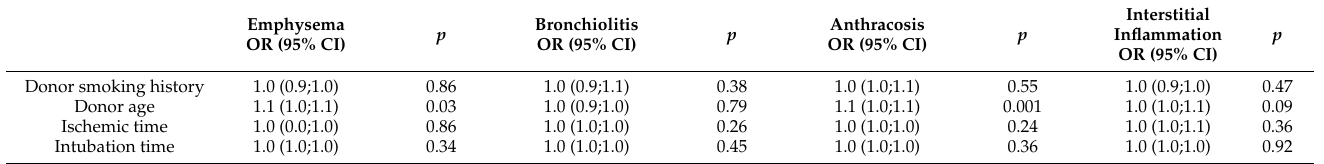
Table 7. Multivariate analysis of variables associated with graft pathology 1